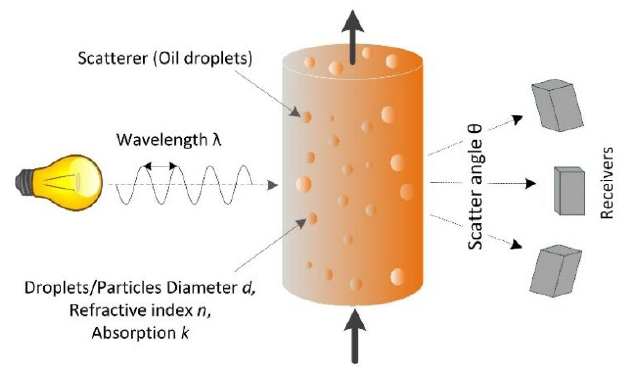
Figure 2. Principles of light scattering.